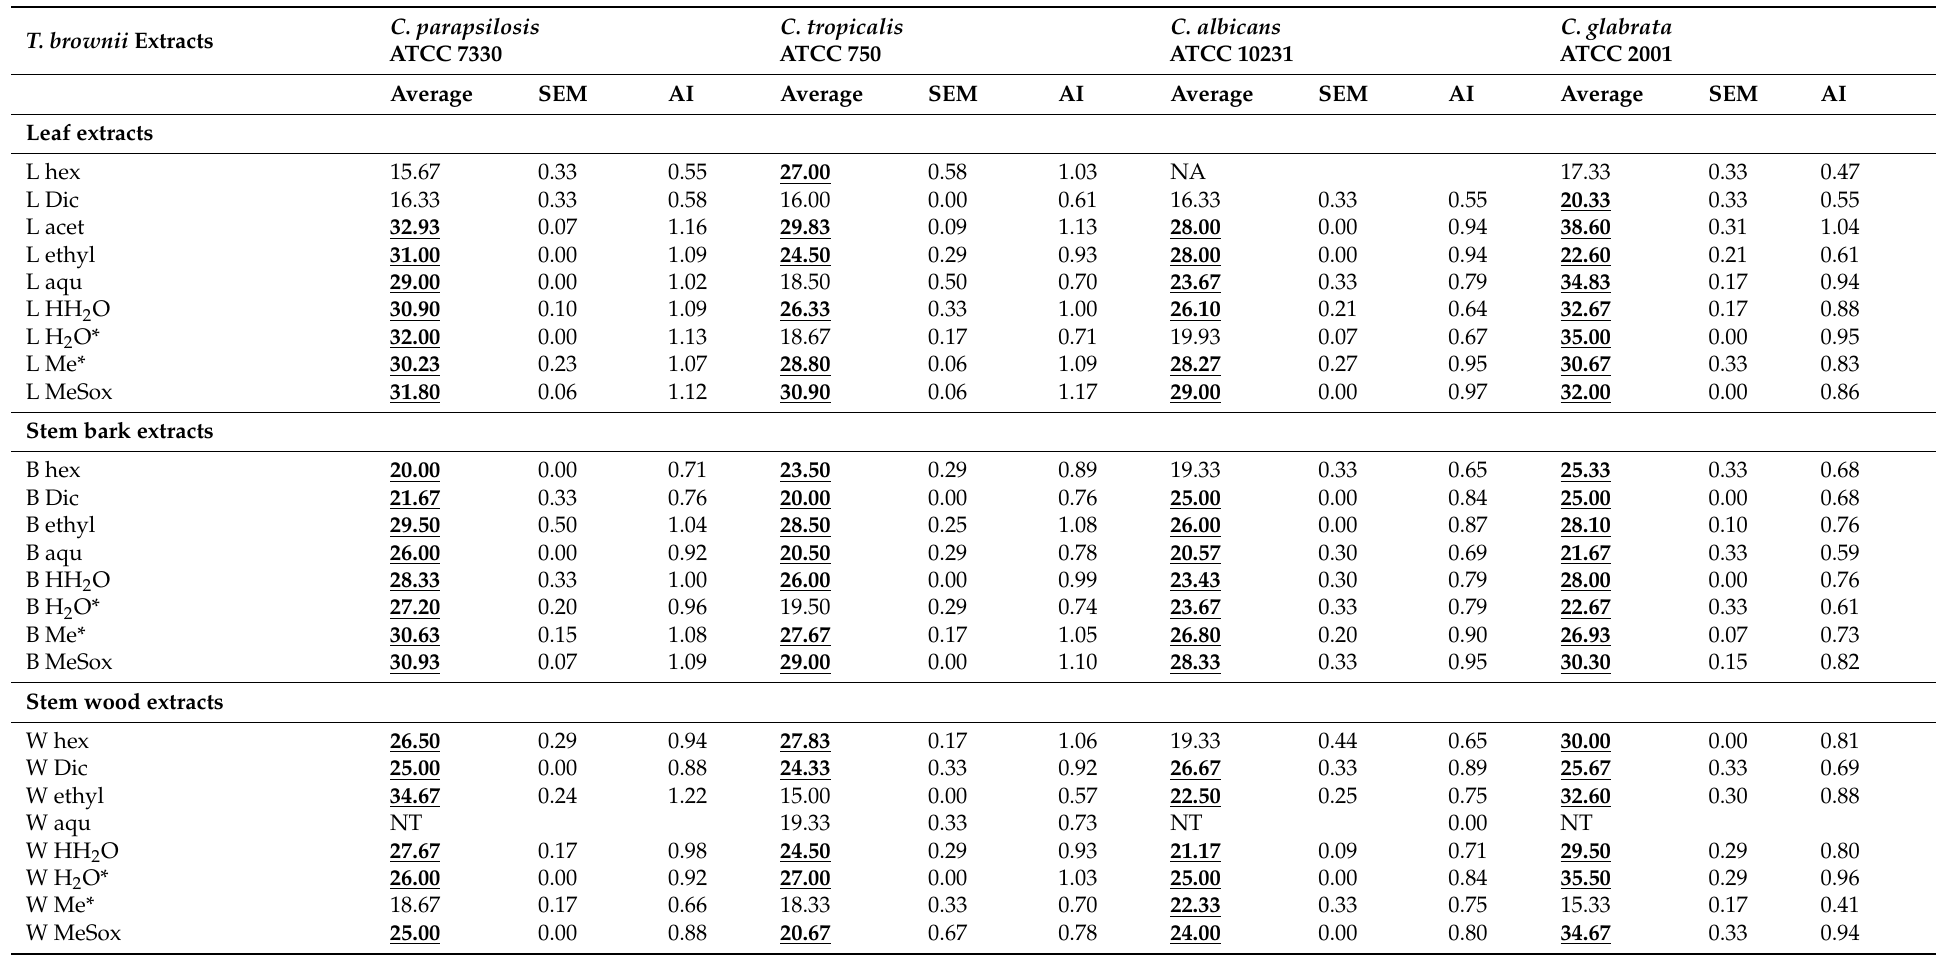
Table 1. Antifungal effects of Terminalia brownii extracts and fractions against human pathogenic Candida spp. Inhibition zone diameters (IZDs) in